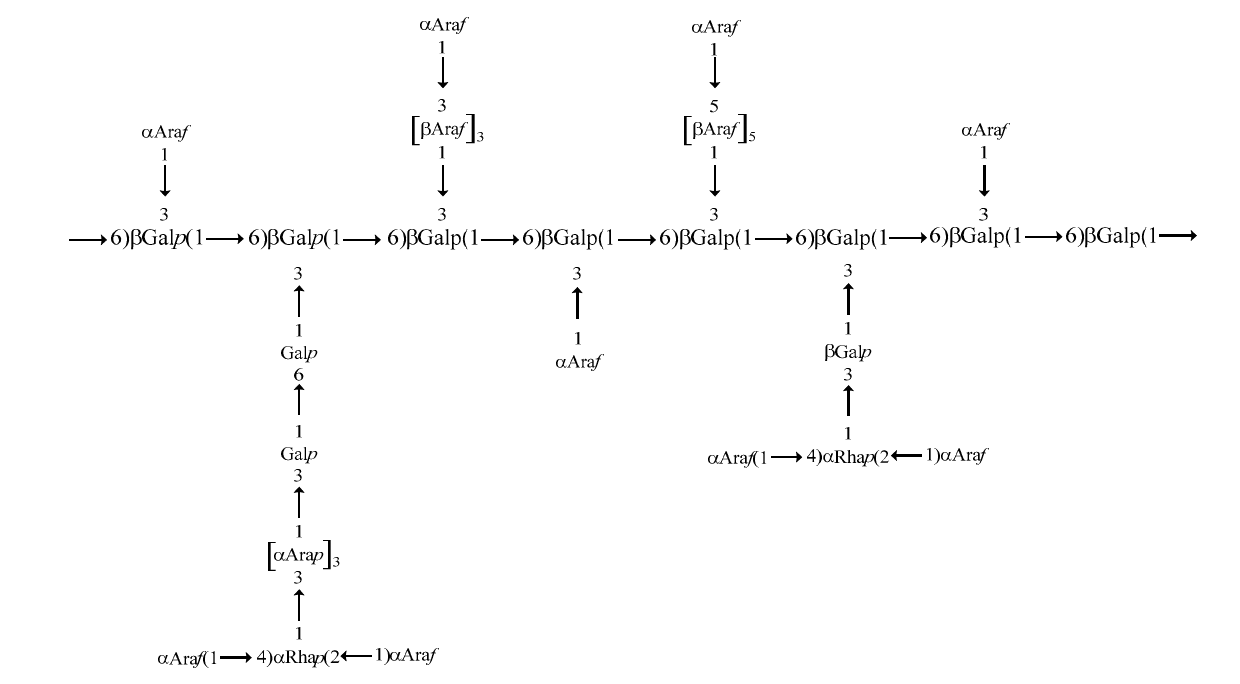
Figure 7. The hypothetical structure of the repeating unit of LRLP—A.